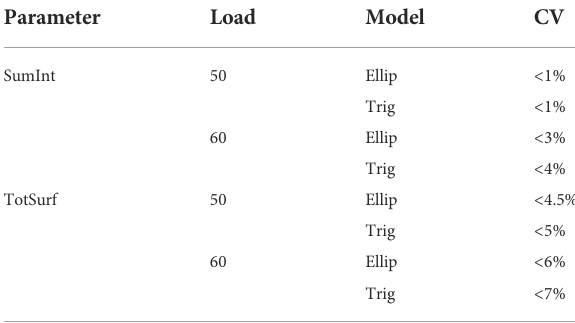
TABLE 7 Repeatability of pressure